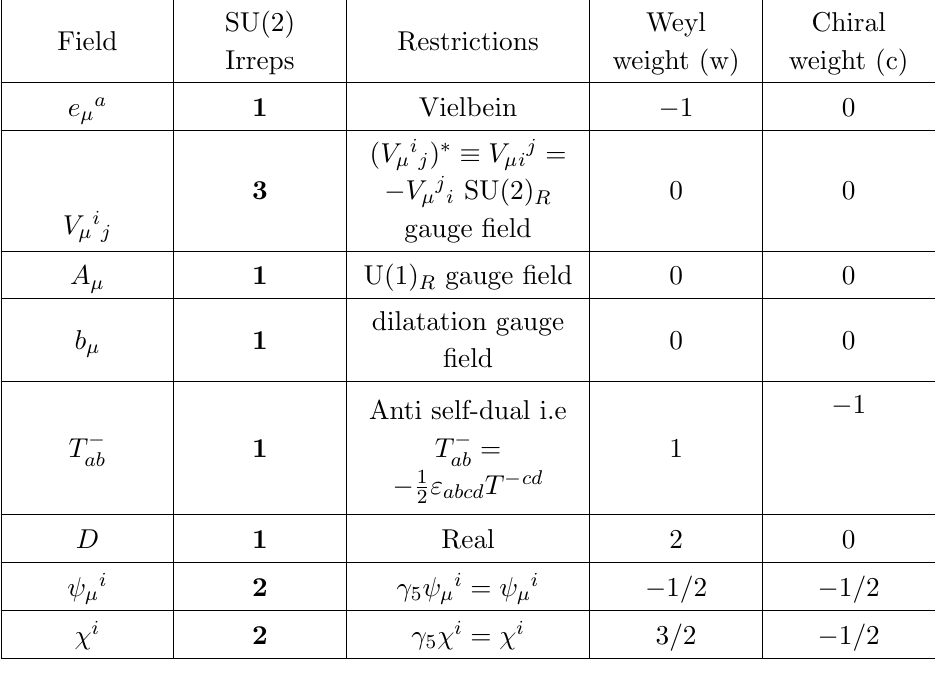
Table 2 . Field content of the N = 2 Weyl